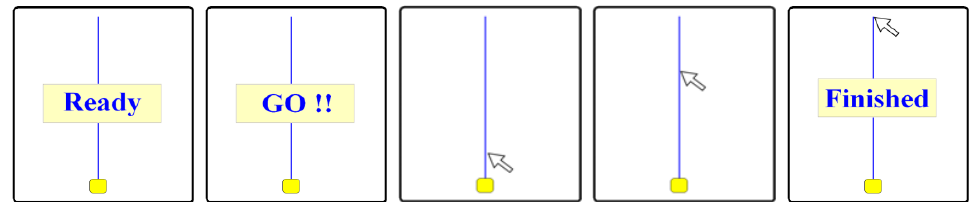
Figure 1. The cursor moving task procedure. Subjects were required to move the arrow tip of cursor starting from the yellow square, which is fixed in the start point, to the end of the straight line. This figure demonstrates the example of moving upward.